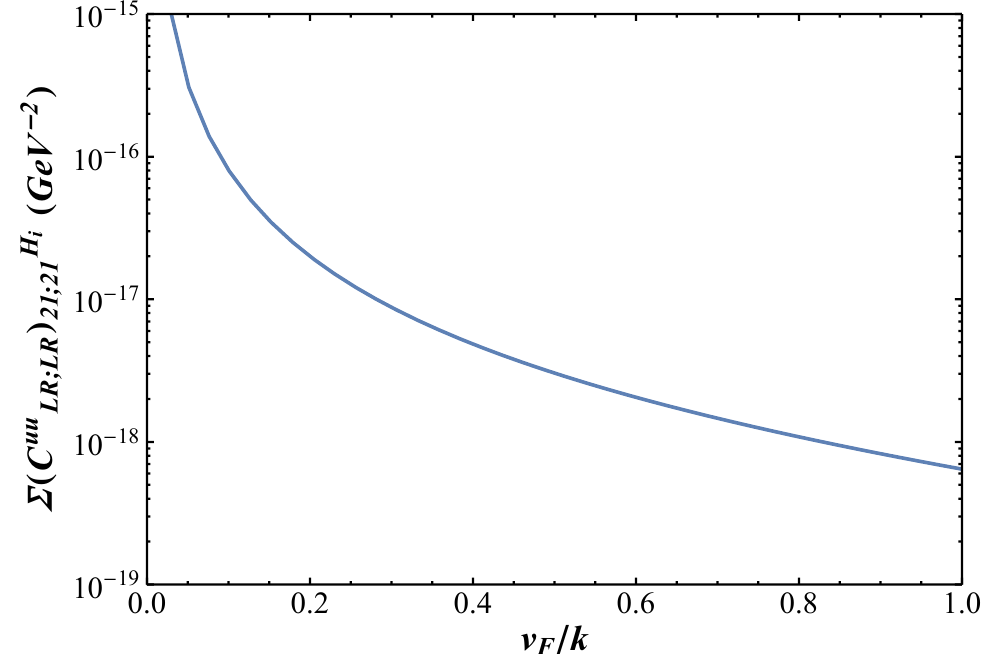
Figure 5. At a sample point in parameter space, the Wilson coe(cid:14)cient P 4 units of GeV (cid:0) 2